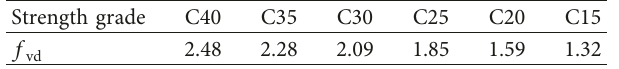
Table 2: Designed concrete shear strength.